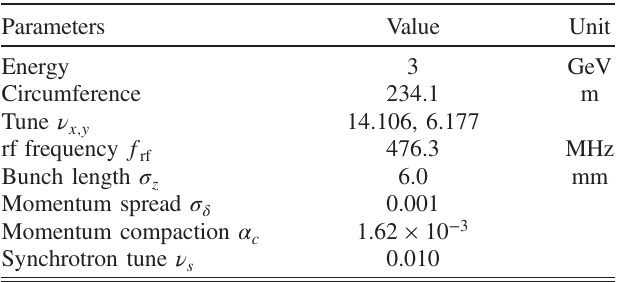
TABLE I. Selected parameters of